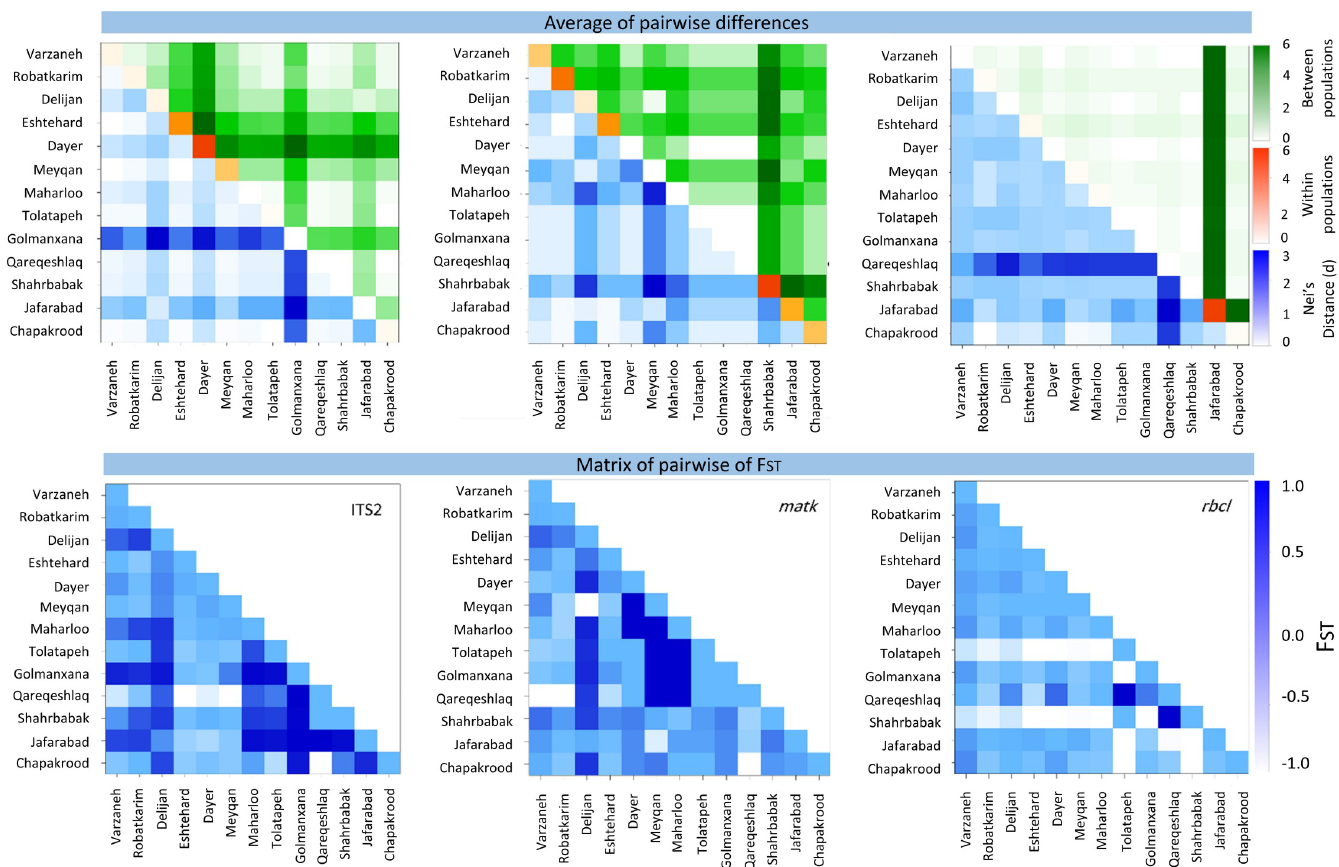
Fig 5. Inter and intra molecular variance analysis and F